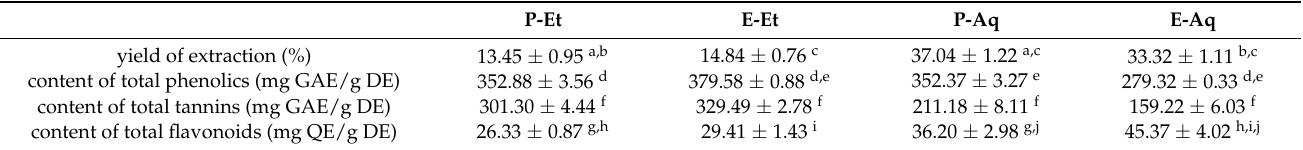
Table 1. Results of the preliminary chemical analysis.